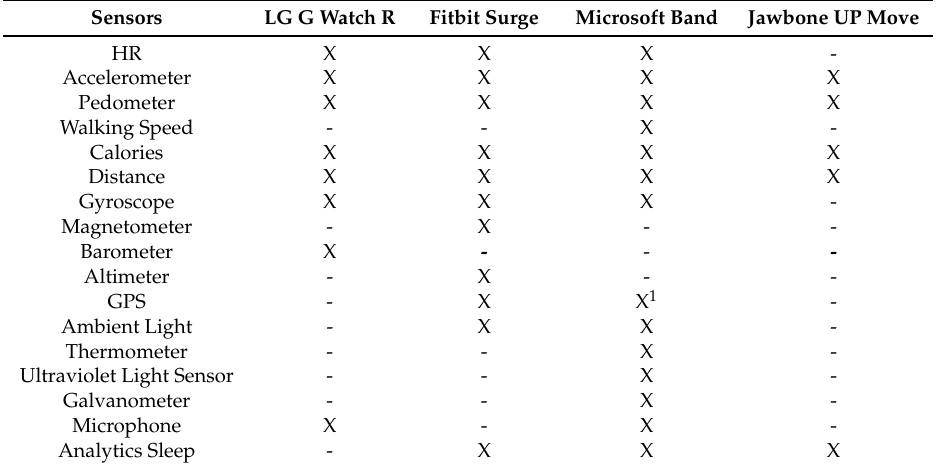
Table 4. Sensors available in the wearables (Notes 1 it is not possible to gain access to this data).